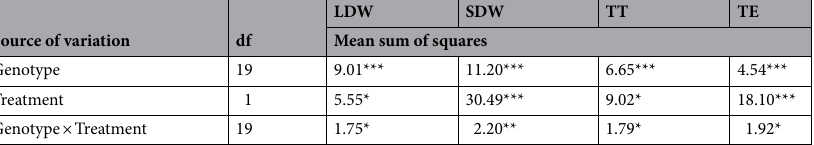
Source of variation